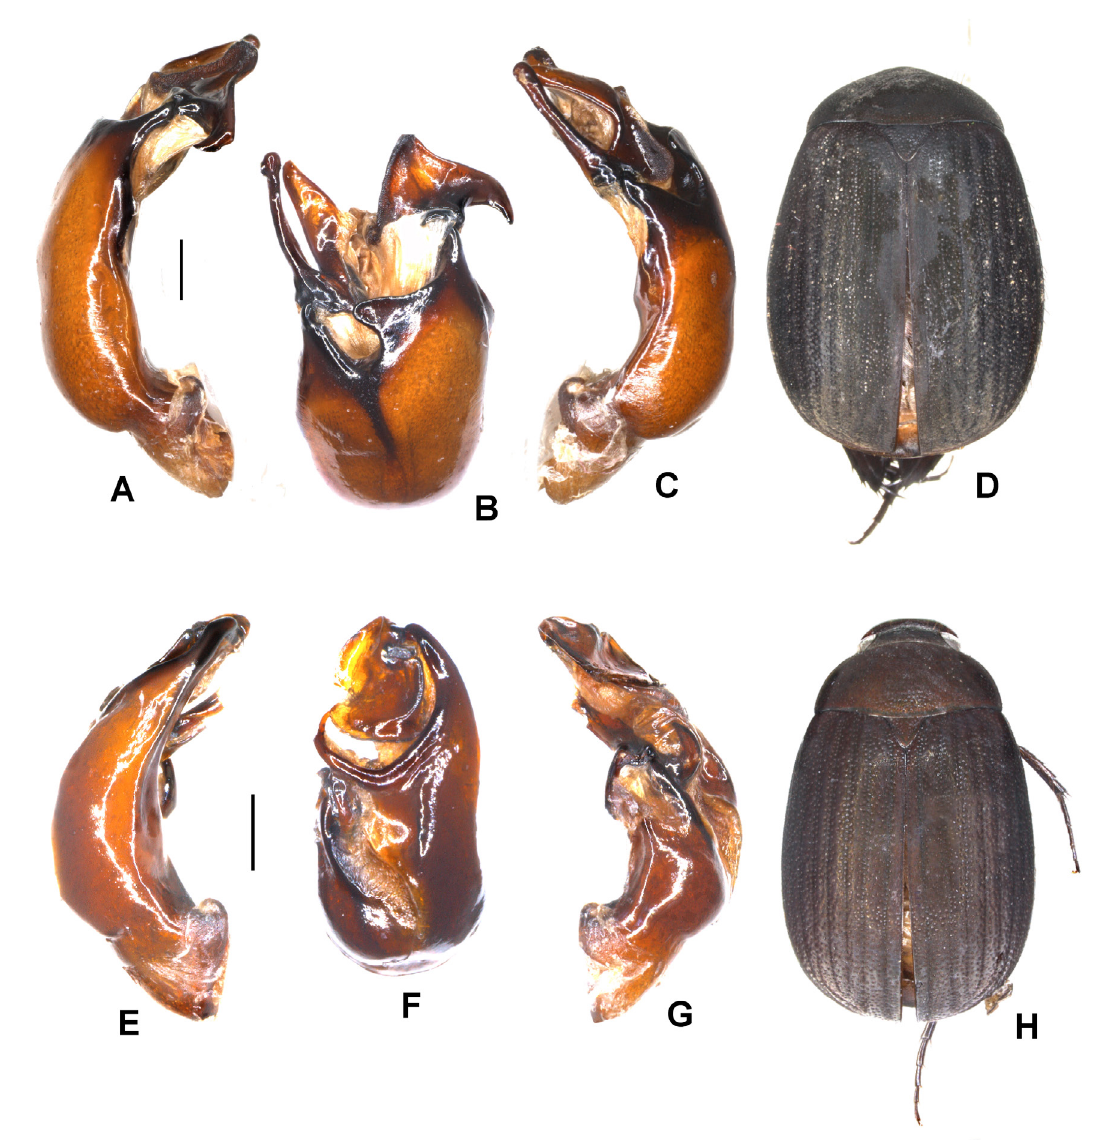
Fig. 1. A–D . Maladera murzini Ahrens, 2004 , India: Nagaland, Medziphema. E–H . M. viraktamathi sp. nov., holotype, ♂. A, E . Aedeagus, left side lateral view. C, G . Aedeagus, right side lateral view. B, F . Parameres, dorsal view. D, H . habitus. Scale bars: 0.5 mm. habitus not to